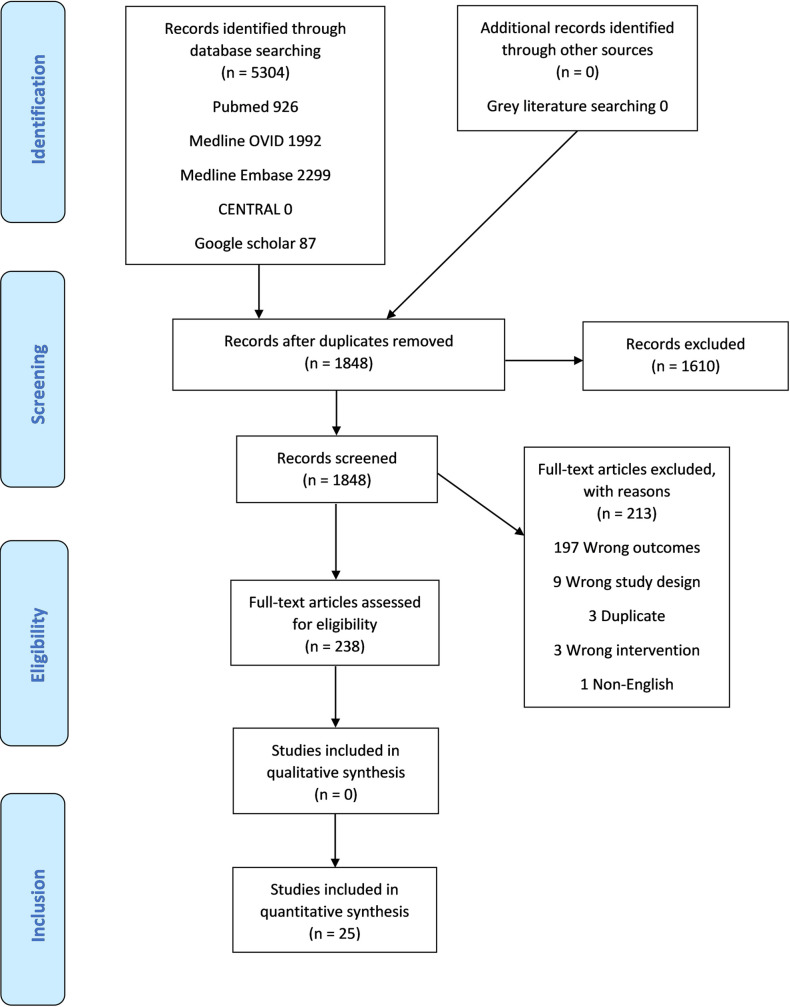
PRISMA flowchart.